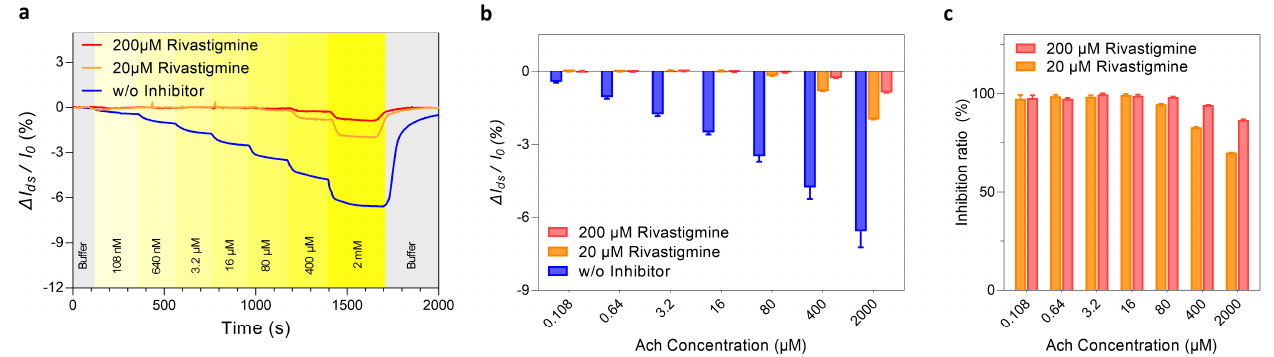
Figure 5. Inhibition effects of rivastigmine on AchE activity tests. ( a ) The real-time responses of AchE-immobilized PGFETs with various rivastigmine concentrations (0, 20, and 200 µ M). ( b ) The ∆ I ds /I 0 responses for a quantitative analysis of inhibition effects depending on rivastigmine concen- trations (0, 20, and 200 μ M). ( c ) Inhibition rates for different concentrations of rivastigmine. The average ± standard deviation was calculated from n = 3 independent samples.